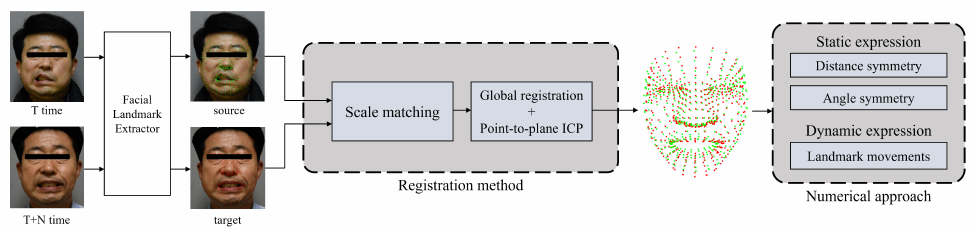
Figure 1. Overall framework of our proposed method. Iterative closet point (ICP) is an algorithm that finds a correlation using the closest point of each data, and moves and rotates the data to register